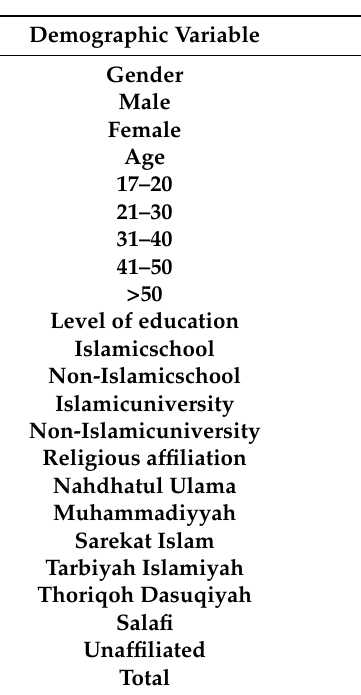
Table 1. Participant